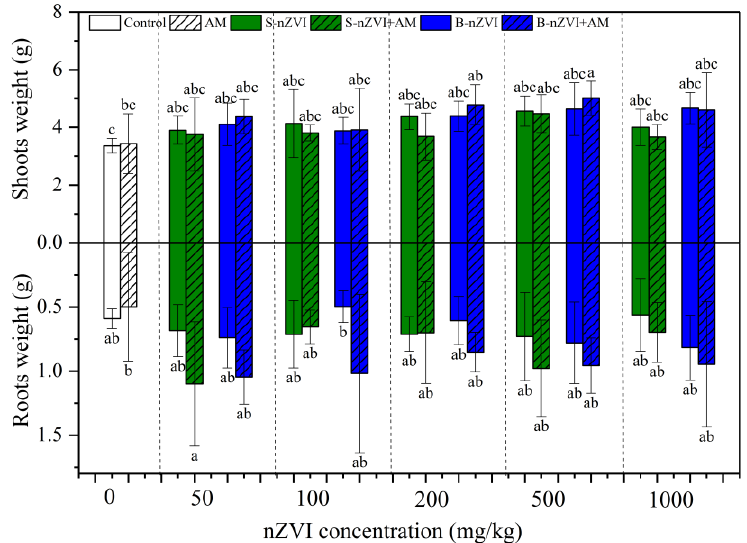
Figure 2. Dry weights of sweet sorghum shoots (above x-axis) and roots (below x-axis). Control represents the treatment without AM inoculation or nZVI; AM represents the treatments inoculated with A. mellea ZZ; S-nZVI represents the treatments that received S-nZVI; S-nZVI+AM represents the treatments that received S-nZVI and AM inoculation; B-nZVI the treatments that received B-nZVI; B-nZVI+AM represents the treatments that received B-nZVI and AM inoculation. Different letters above or below the bars indicate significant differences ( p < 0.05). Three-way and two-way ANOVA results are shown in Tables 2 and 3, respectively. Table 3. Significance levels ( F values) of AM inoculation, nZVI, and their interactions on measured parameters on a two-way ANOVA analysis. S-nZVI B-nZVI Variable AM Conc. AM × Conc. AM Conc. AM ×